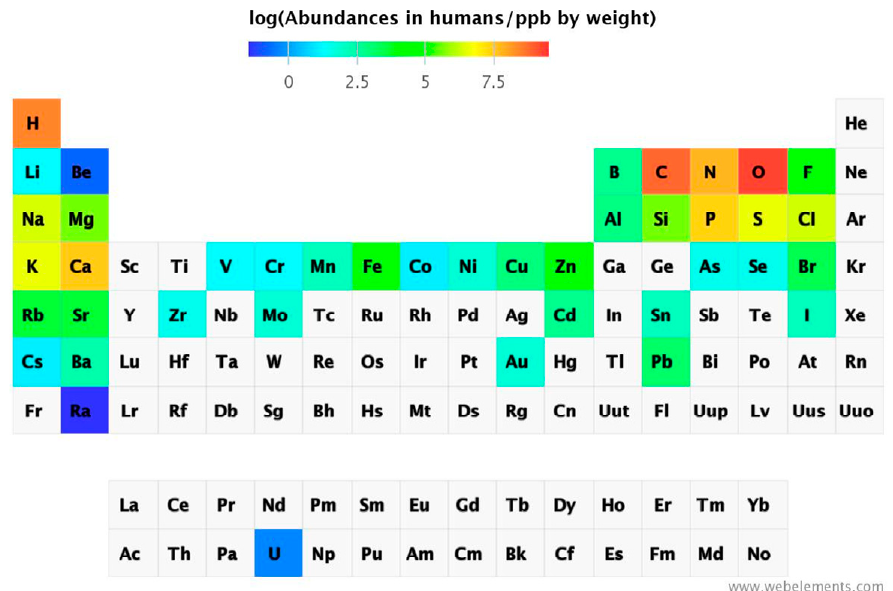
Figure 3. Abundance of the chemical elements in humans [18].